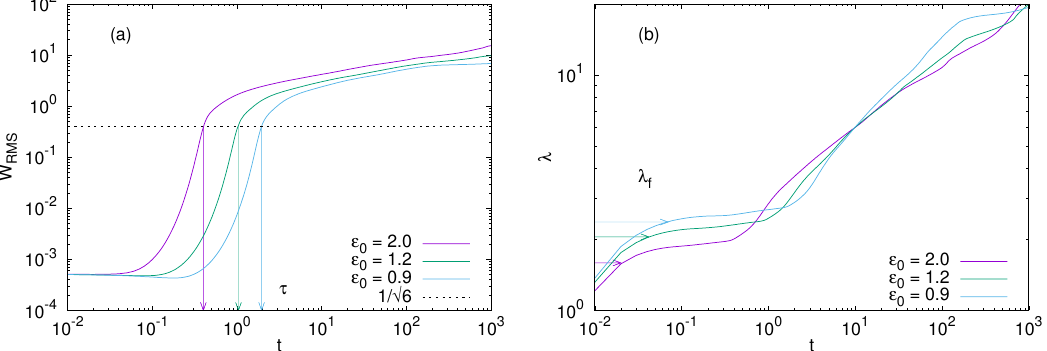
Figure 8. Time evolution of ( a ) the root mean square of w (related to the amplitude of wrinkles, b ) the average wavelength of wrinkles. The arrows in ( a ) indicate the time when W RMS = 1/ in ( b ) indicate the wavelength λ f = 2 π / k f of the fastest mode, which is given by Equation